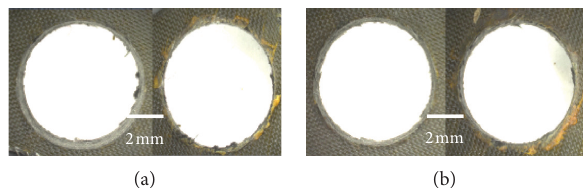
Figure 20: Comparison of two holes. (a) Original sets. (b) Improved